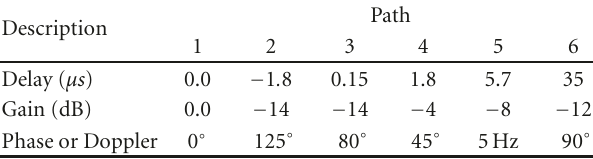
Table 3: ATSC R2.1 channel multipath